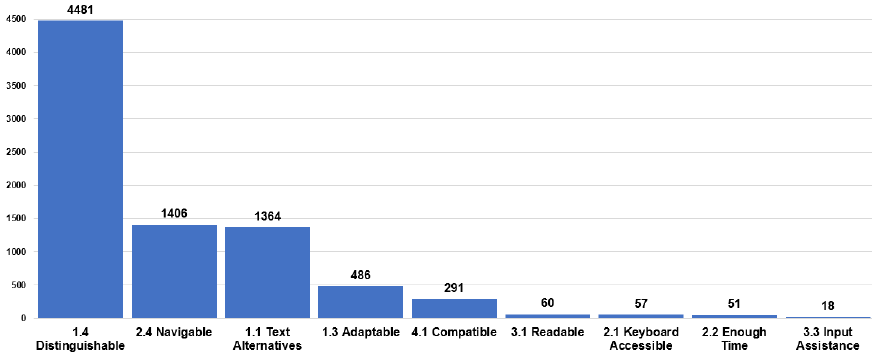
Figure 4. Summary of the identified accessibility guidelines.